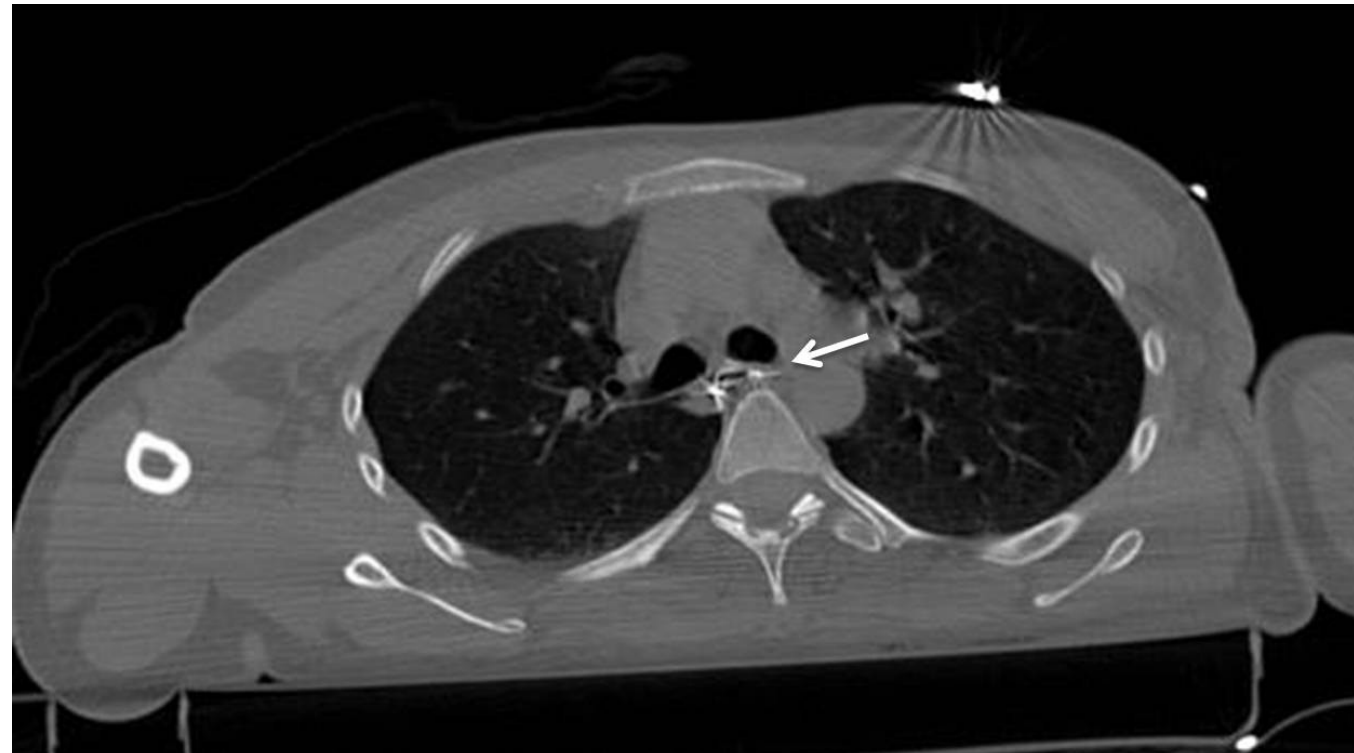
Figure 2. Thoracic computed tomography with oral contrast enhancement showing extraluminal contrast material from the